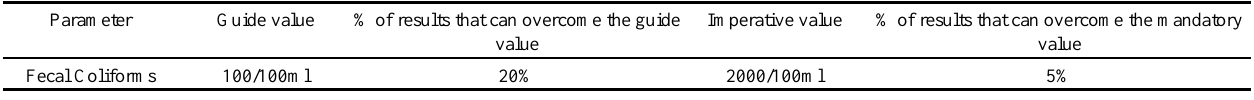
Table 1 . BFA fecal coliform thresholds, as defined by EC Bathing Water Directive of 1976